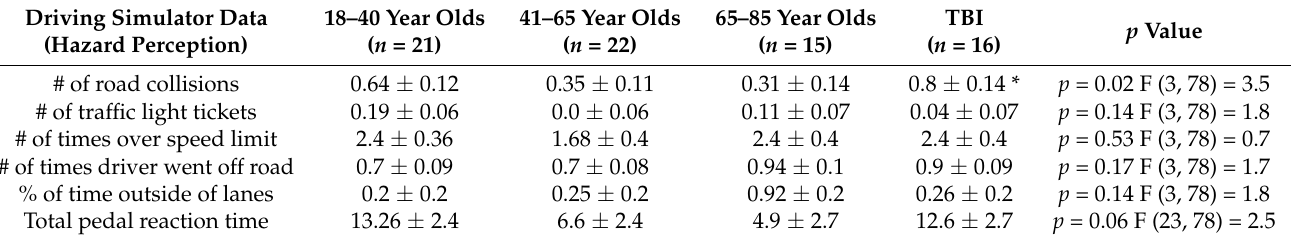
Table 4. Driving simulator data.